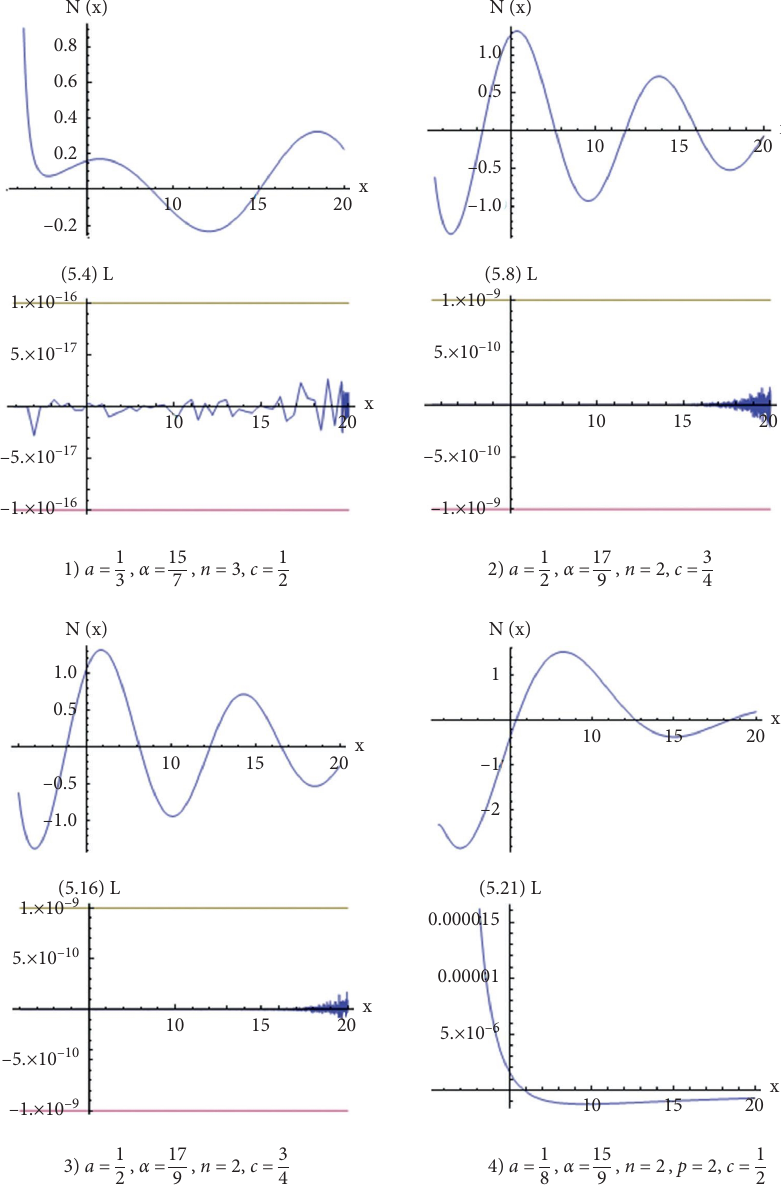
Figure 1: Te solution curves and the error curve of the